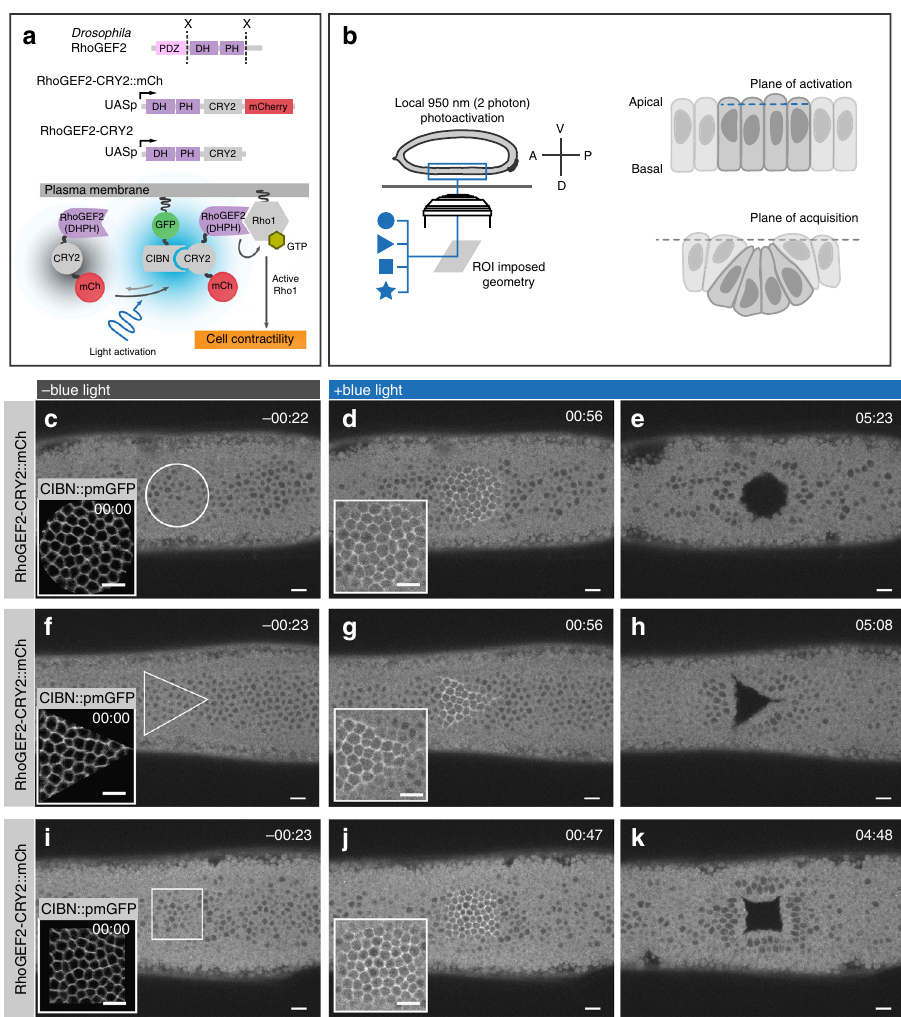
Fig. 1 Light-mediated recruitment of RhoGEF2 at the plasma membrane causes tissue-level responses. a Schematic illustration of the CRY2/CIBN optogenetic system used for controlling plasma membrane recruitment of the Rho1 activator RhoGEF2 during early Drosophila embryogenesis. The DHPH catalytic domain of the GTP Exchange factor RhoGEF2 was fused to the light-sensitive PHR domain of CRY2 and either tagged with mCherry or left without a fl uorescent tag. In the absence of light, RhoGEF2-CRY2::mCherry localizes to the cytoplasm (left). Upon two-photon illumination, CRY2 undergoes a speci fi c conformational change and binds to the plasma membrane anchor CIBN::pmGFP (right). At the plasma membrane, RhoGEF2-CRY2::mCherry triggers activation of Rho1 and its downstream effectors. b Cartoon illustrating the experimental setup used in this study. Stage 5 Drosophila melanogaster embryos expressing the optogenetic module were mounted with their dorsal epithelium facing the coverslip, and a region of interest (ROI) of the desired geometrical pattern (left) was de fi ned to delimit the area of two-photon illumination. The plane of activation was restricted to the junctional plane at 4 µ m from the apical side of the epithelium (right top); over time photo-activated cells disappeared from the plane of acquisition (right bottom). c – k Confocal still frames from time-lapse recordings of three representative embryos ( N = 9) co-expressing CIBN::pmGFP and RhoGEF2-CRY2::mCherry. Images are presented as integrated intensity projections of 3 µ m. c In the absence of blue-light (~20s before photo-activation), RhoGEF2-CRY2::mCherry localizes to the cytoplasm. Inset shows the plasma membrane localization of CIBN::pmGFP at the time of photo-activation using two-photon illumination. d RhoGEF2- CRY2::mCherry recruitment to the plasma membrane was restricted to the imposed circular area after eight consecutive rounds of photo-activation for a total time of 2 s. In depth, the area of activation was restricted to three consecutive z-stacks centered at 4 µ m from the apices of the cells. Inset represents a magni fi cation of the activated area. e Sustained photo-activation was alternated with mCherry excitation and recorded in intervals of ~21 s. After ~5 min, a hollow matching the geometrical pattern of photo-activation formed on the dorsal epithelium as photo-activated cells disappeared from the plane of acquisition. Similar experiments were carried out with a triangle ( f – h ) and a square ( i – k ). Scale bars are 10 µ contraction and expansion of the surface area, as seen during activation protocol was based on a continuous and synchronous dorsal closure 43 , or of contraction and stabilization, as seen administration of light, which might override any potential pul- during ventral furrow formation 44 . The apical constrictions satile behavior induced by endogenous biochemical or mechan- induced by optogenetic stimulation of RhoGEF2 displayed a ical processes downstream of Rho signaling. Therefore, we monotonic increase and decrease in the constriction rate over a monitored apical constriction under different illumination con- period of ~8 min (Fig. 2h) without showing any obvious pulsatile ditions. First, we tested whether changing the frequency of illu- behavior in a cell-by-cell analysis of the constriction rate (Fig. 2i), mination without modifying the laser power (10 mW) would be thus arguing that the average contractile behavior did not obscure suf fi cient to elicit pulsatile constrictions. The results from these any underlying individual pulsatile behavior. Our initial photo- experiments demonstrated that, at intervals of ~55 s of